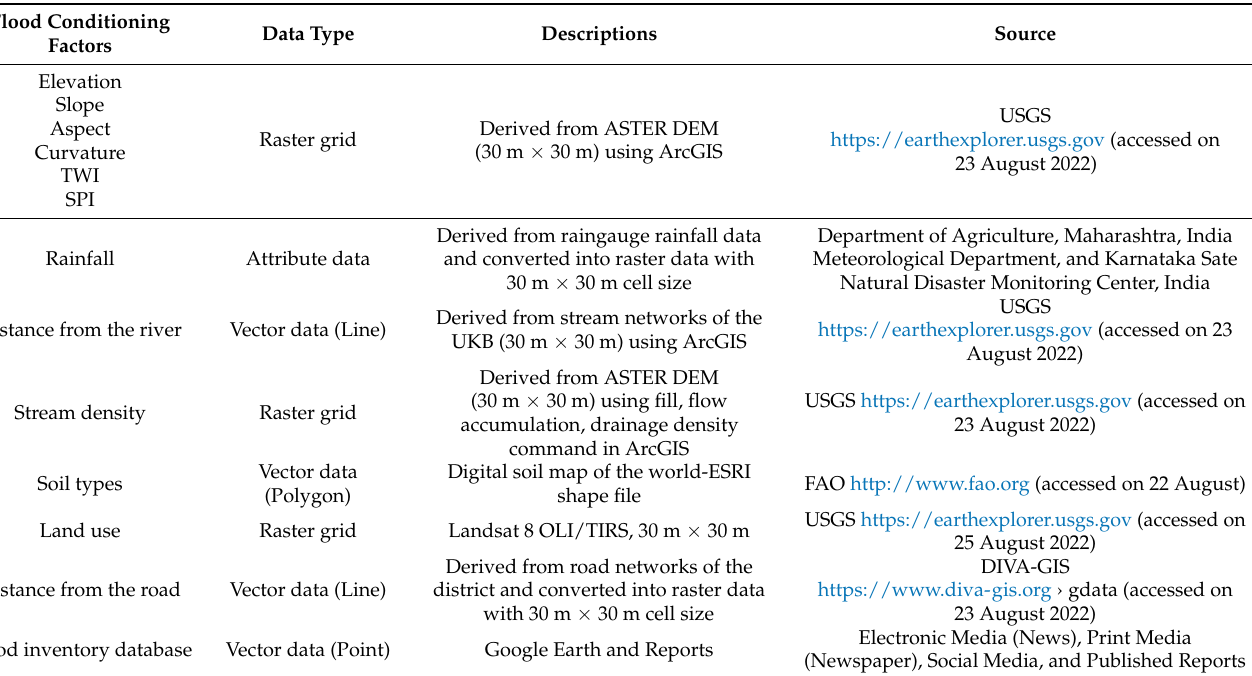
Table 1. Parameters used for flood susceptibility mapping, their sources, and descriptions.